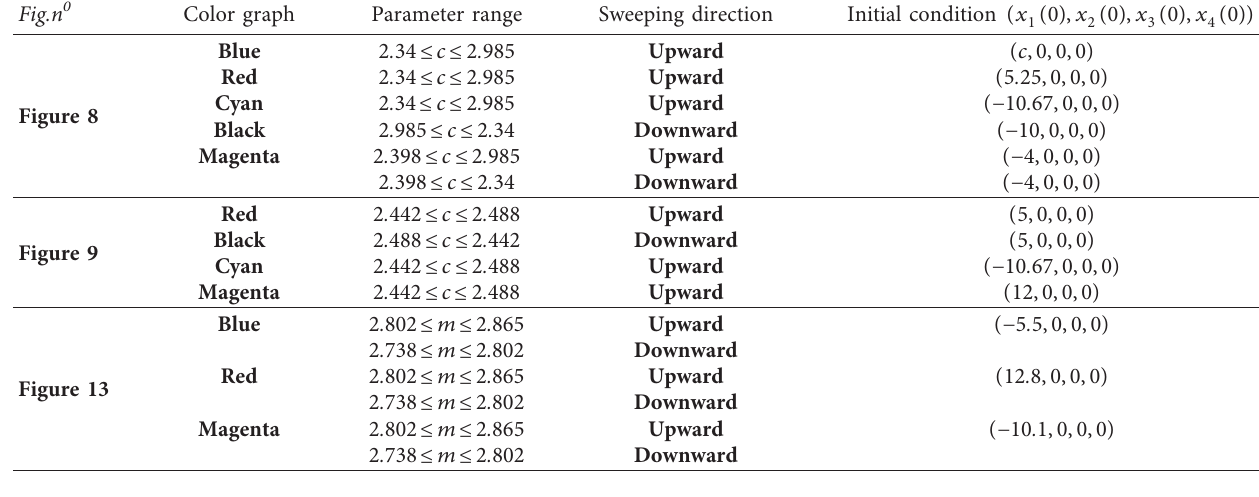
Table 3: Techniques used to obtain coexisting bifurcation diagrams and corresponding initial conditions. Fig.n 0 Color graph